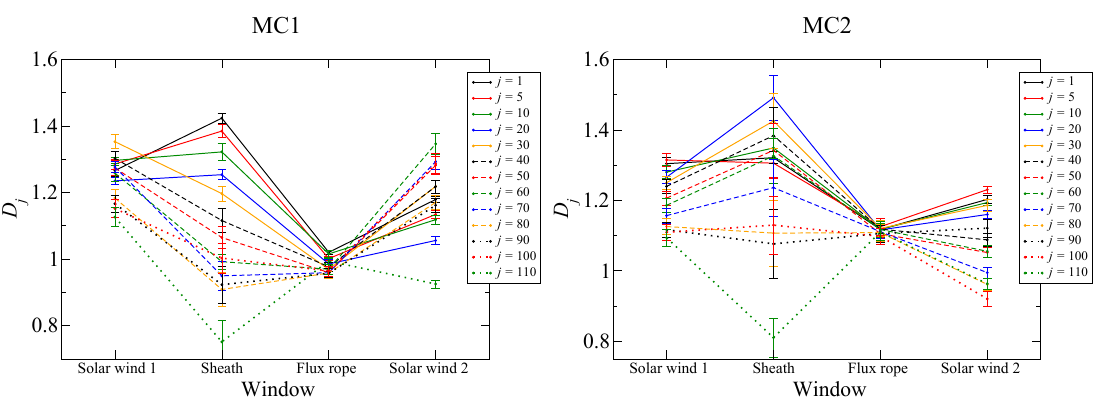
Figure 10. Box-counting fractal dimension for two magnetic cloud events during the four stages of the time series: first the solar wind, then the sheath, then the flux rope, and finally the solar wind again. Several values for data sampling j are